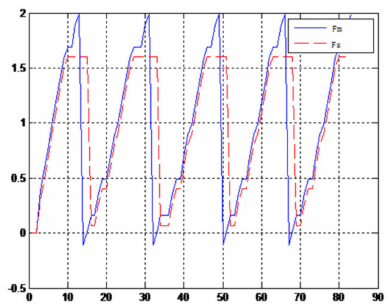
Figure 26. Force feedback wave along x axis. (No time delay, elastic ball).